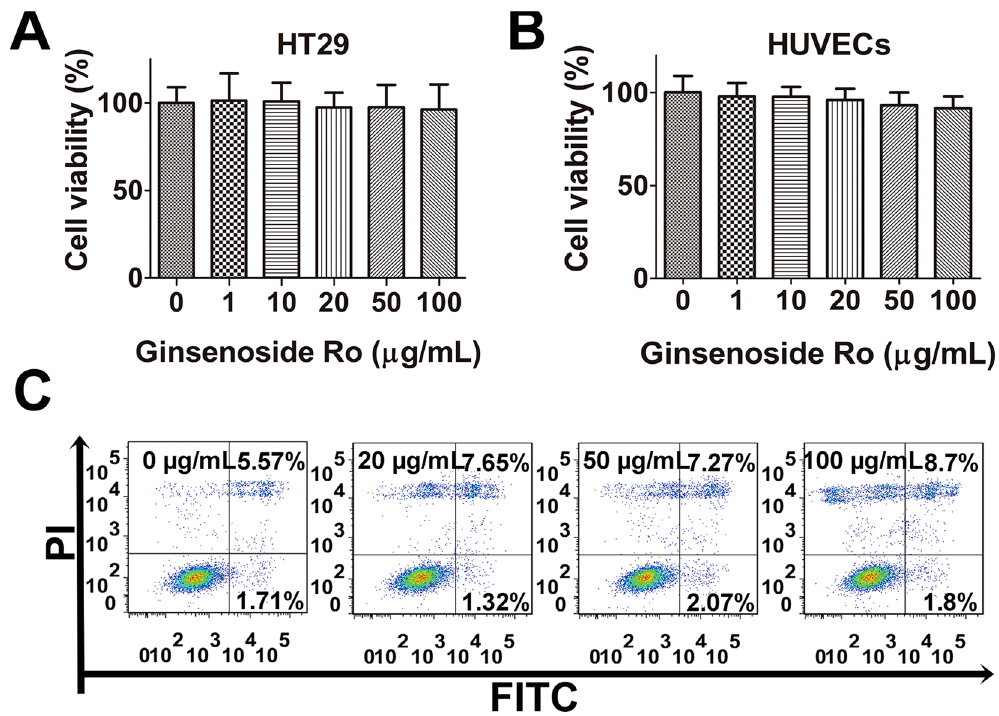
Figure 3. Effects of ginsenoside Ro on cell viability and proliferation. ( A ) and ( B ) Ginsenoside Ro within 100 μ g/mL produced no significant cytotoxicity against human colon cancer HT29 cells and endothelial HUVECs. ( C ) Flow cytometric analysis showed no significant apoptotic signs in the HT29 cells treated with ginsenoside